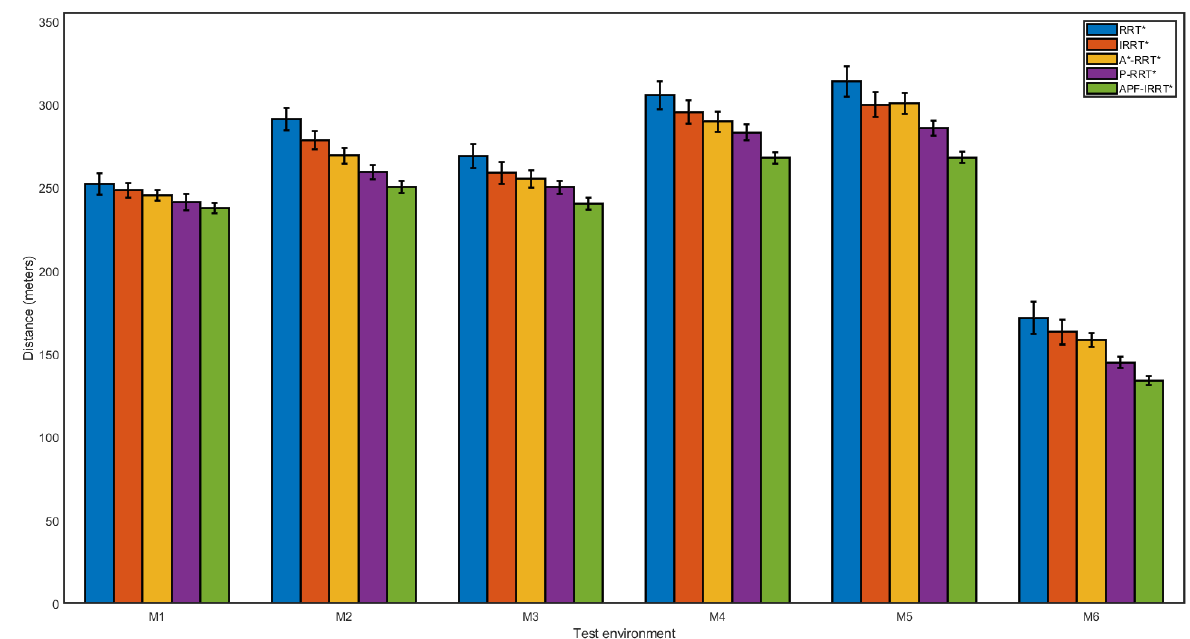
Figure 7. Comparison of path length for five algorithms in six different test environments.